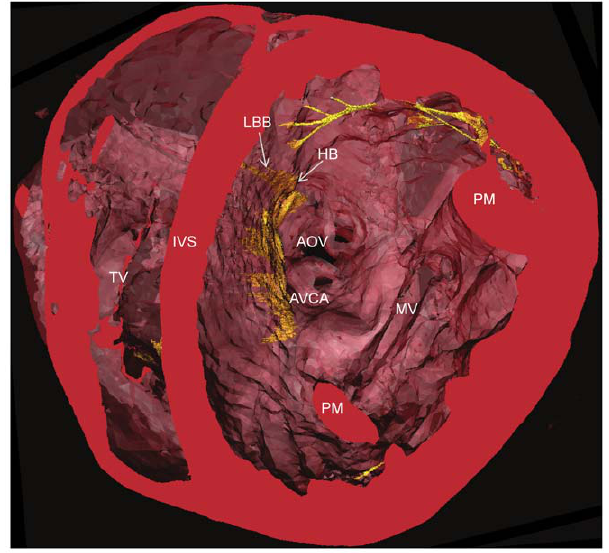
Figure 8. Trasnsverse course of the atrioventricular conduction axis. Rabbit heart segmented 3D surface, cropped transversely to show the relationship of the conducting tissue (yellow) with the surrounding cardiac mass (red) as it transverses the top of the interventricular septum. AOV- aortic valve, AVCA- atrioventricular conduction axis, HB- His bundle, IVS- interventricular septum, LBB- left bundle branch, MV- mitral valve, PM- papillary muscle, TV- tricuspid valve.